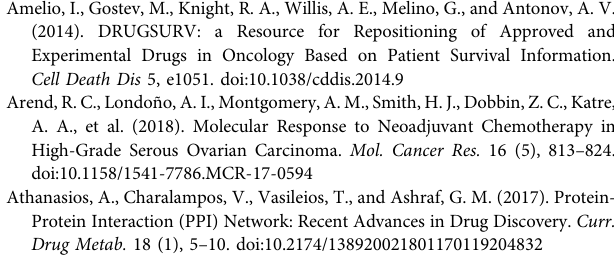
Supplementary Figure S3 | Correlation of ADARB1 expression with immunostimulators, immunoinhibitors, and MHC molecules in GBM. (A) The correlation between ADARB1 expression and immunostimulators. And the top four immunostimulators showing the most signi fi cant correlation with ADARB1